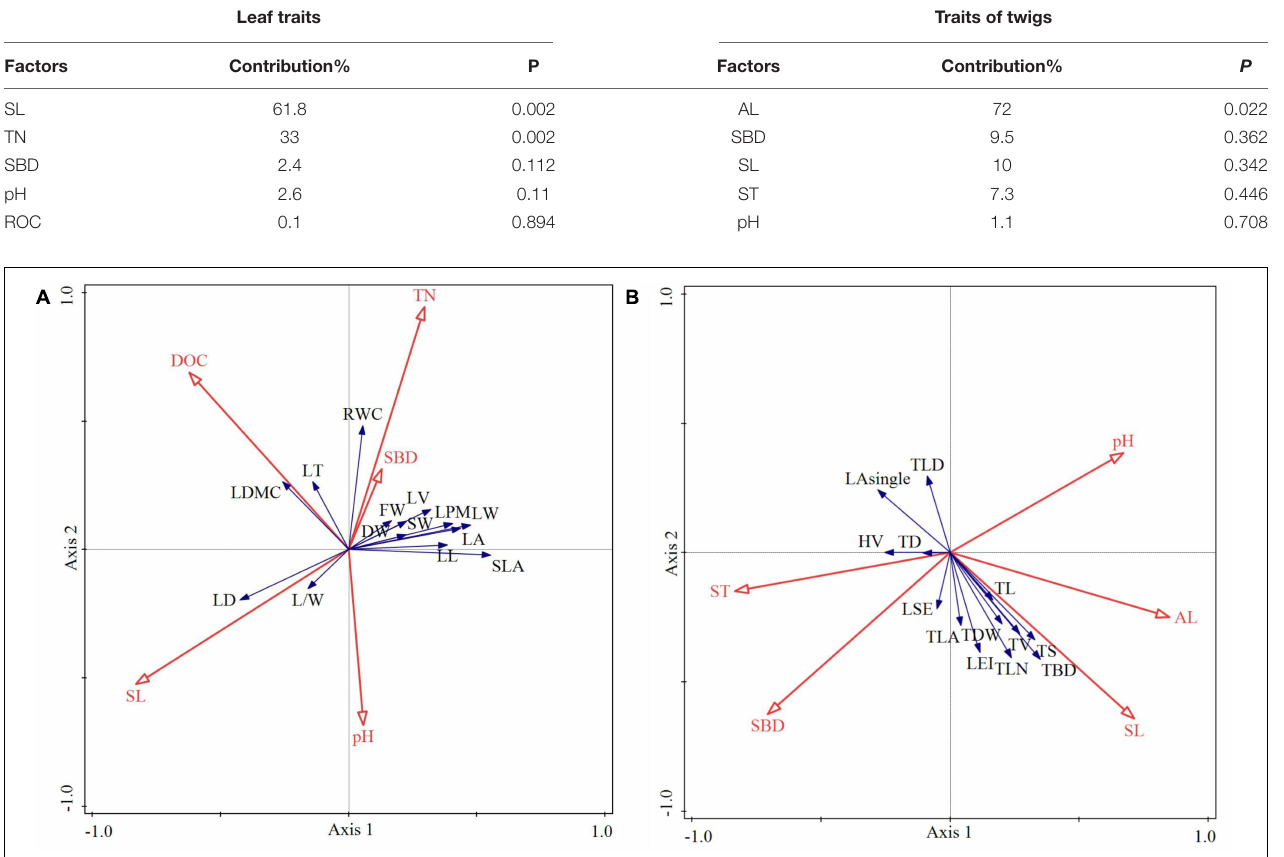
FIGURE 7 | RDA analysis of leaf functional traits (A) , functional traits of current-year twigs (B) and environmental factors.